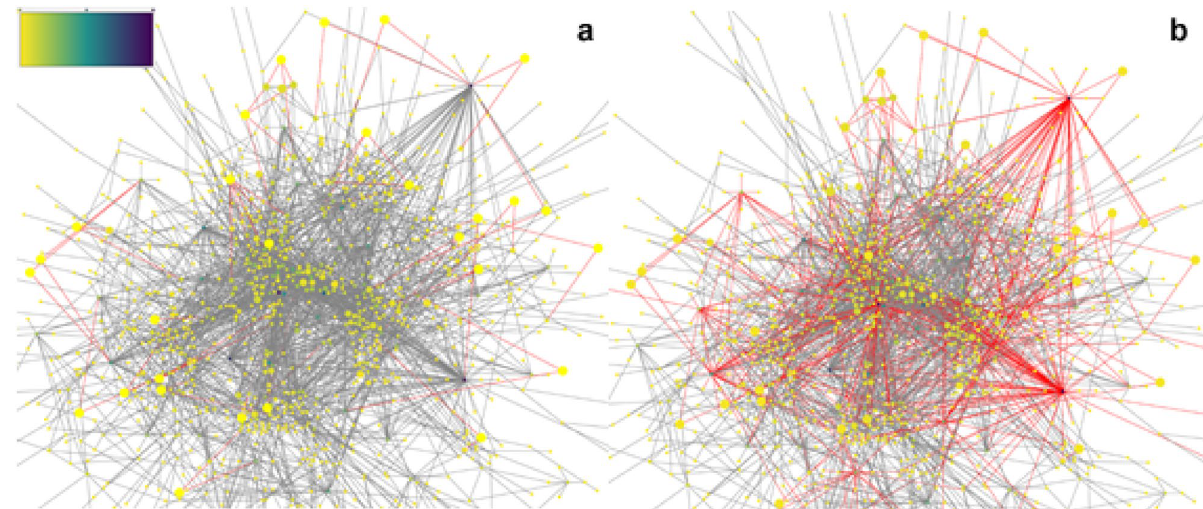
Figure 2. DGE-PPI network. ( a ) It represents a gathering and merging of the DGE analysis results and the Human Protein–Protein Interaction network from the Mentha Database. Red lines represent the connections of the gatekeepers. Color scale is presented in the left top corner. It represents the color scale applied to show graphically the values in the centrality measure for each node in the networks. ( b ) The red lines represent the connections of the gatekeepers plus the connections of its first neighbors (direct connected nodes to gatekeepers). The red lines comprise most of the network connections. ( a,b ) The proteins with less connections are marked in yellow and the most connected proteins are marked in navy blue purple. The size of each node represents the value of the clustering centrality measure; The bigger, the more value it